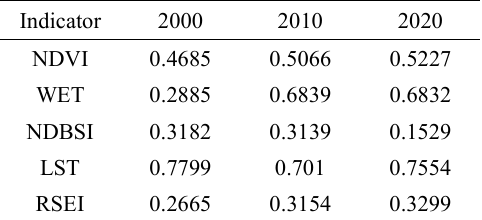
Table 2 . Average of component indicators and RSEI.